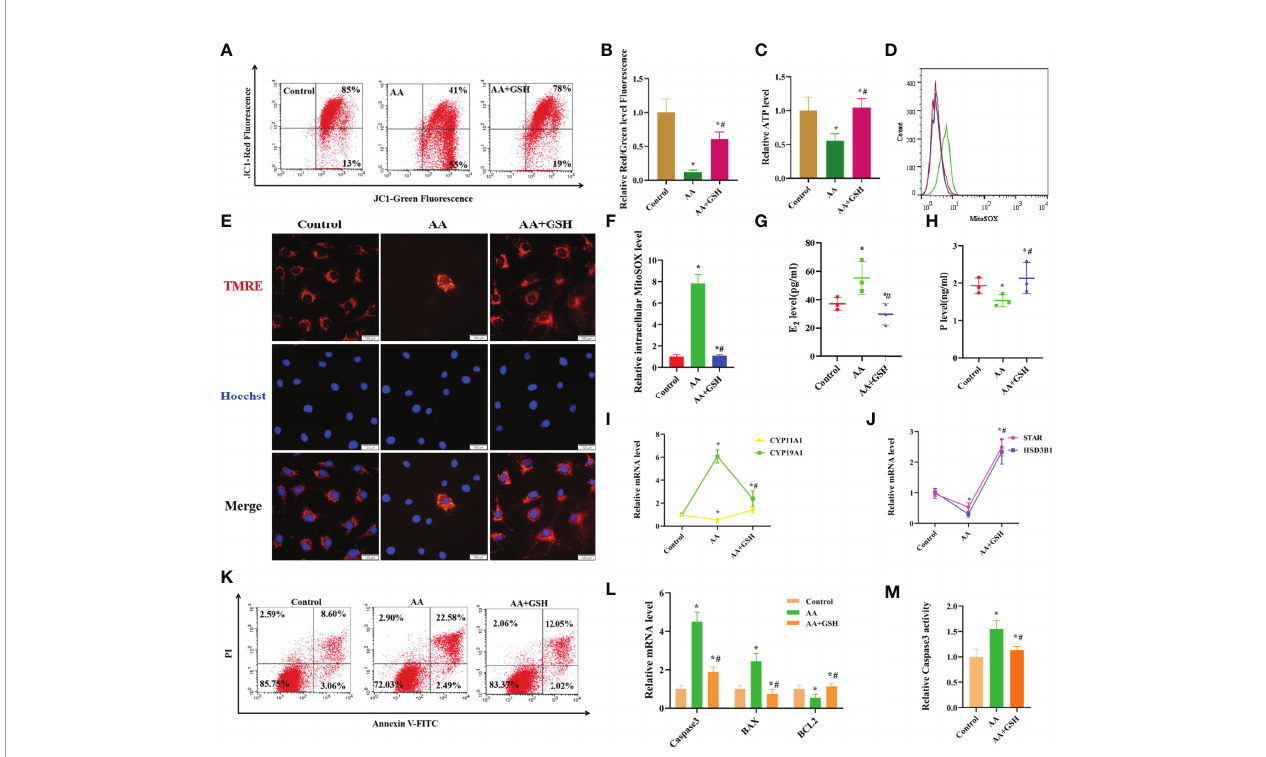
FIGURE 3 | AA caused damage to secretory and mitochondrial functions of KGN cells. (A, B) After AA treatment, mitochondrial membrane potential was distinctly decreased. (C) The mitochondrial function indicators ATP level was decreased. (D, F) the level of intracellular mitoSOX was increased. (E) The TMRE level in KGN cells was measured after AA inhibition and addition of exogenous GSH. (G – J) KGN cells exposing to AA exhibited an aberrant secretion function including promoting estrogen secretion and inhibiting progesterone secretion concomitant with the upregulation of CYP19A1 and the downregulation of STAR, CYP11A1,HSD3B1. (K, L) Exposing to AA promoted KGN cells apoptosis rate together with abnormal expression of Caspase3 、 BAX and BCL2. (M) Exposing to AA promoted Caspase3 activity. Data represent mean ± standard error, *P < 0.05, * # P < 0.05.Bar = 100 m